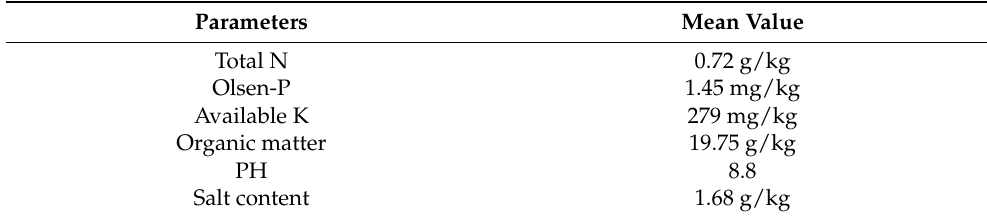
Table 1. Soil characteristics at Dafeng experimental